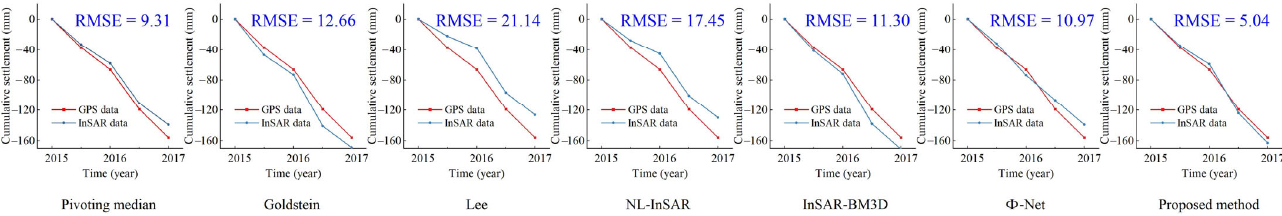
Figure 13. Comparison of InSAR results and GPS data for validation.